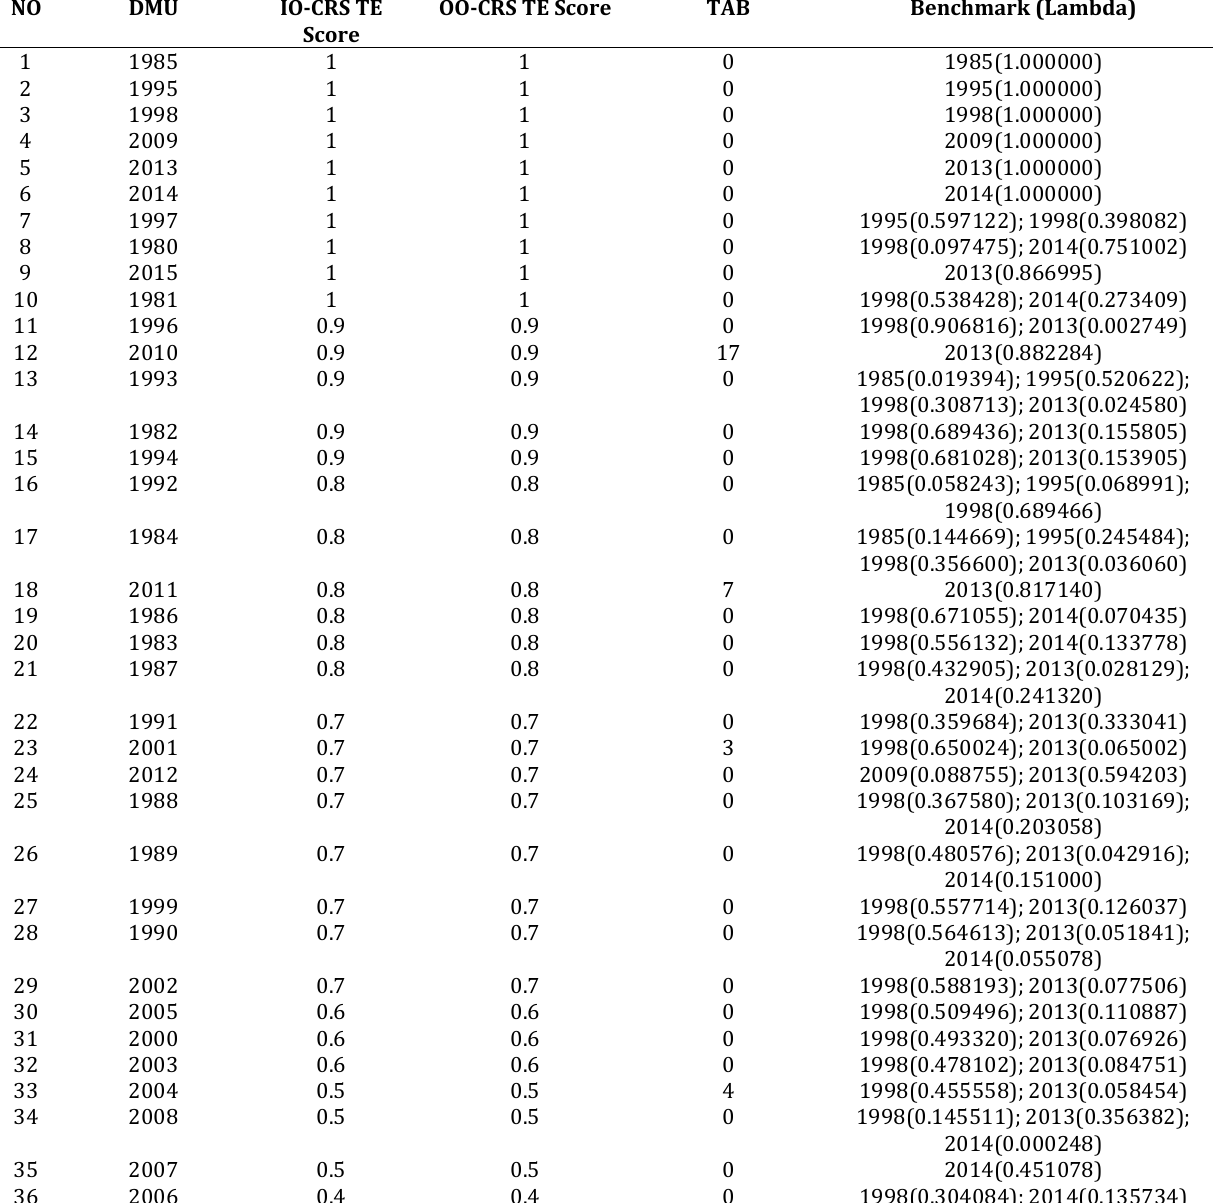
Table 6: Input-Oriented Technical Efficiency Benchmarking for Tin Can Island Port